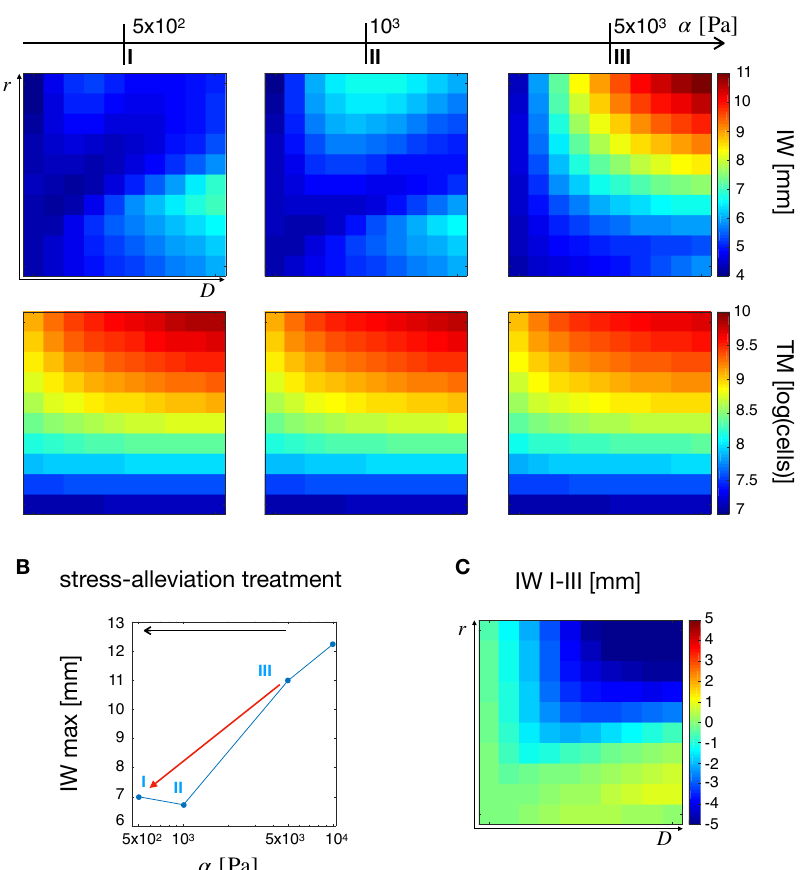
Figure 5. Tumor observables and the effects of a stress-alleviation therapeutic strategy in the case of nutrient-induced phenotypic switching. ( A ) From left to right, simulation maps of tumor IW and TM for varying tissue stiffness from 5 × 10 2 Pa to 5 × 10 3 Pa. A non-trivial effect of stiffness on IW and a monotonic decrease in TM for increasing values of α is observed. ( B ) Maximum value of IW for different tumor stiffness values. The red arrow points in the direction of a stress-alleviation treatment, where shorter IWs are obtained for decreasing values of α . ( C ) Simulation map for the difference in IW between the points I and III in B. Gliomas with the highest values of D and r display the highest